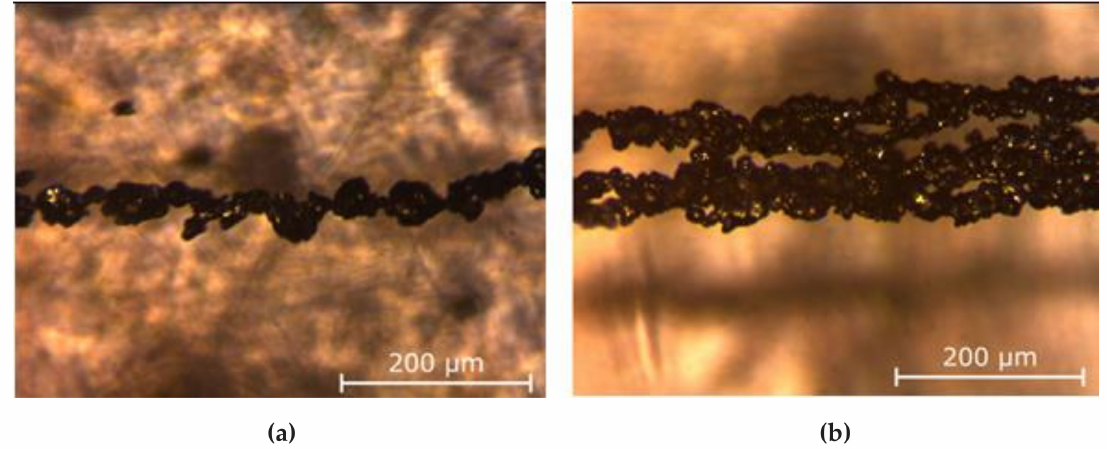
Figure 12. Microscopic images of a single thin chain ( a ) and bulk structure / thick chain ( b ) of magnetic particles similar to the structures shown in Figure 11. The images were kindly provided by Dmitry Borin (TU Dresden) and were obtained using methods equivalent to those given in [103] and shown in Figure 11. Adopted from